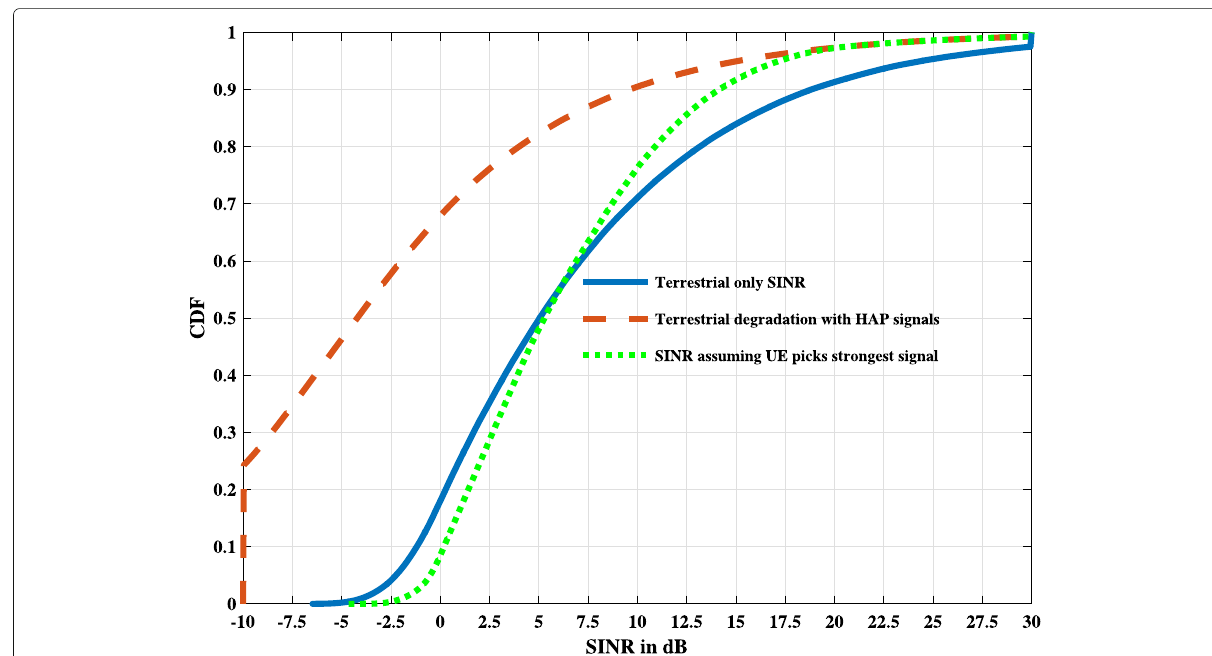
Fig. 10 CDF of SINR before and after placement of a Loon HAP over a 3 cell terrestrial rural deployment